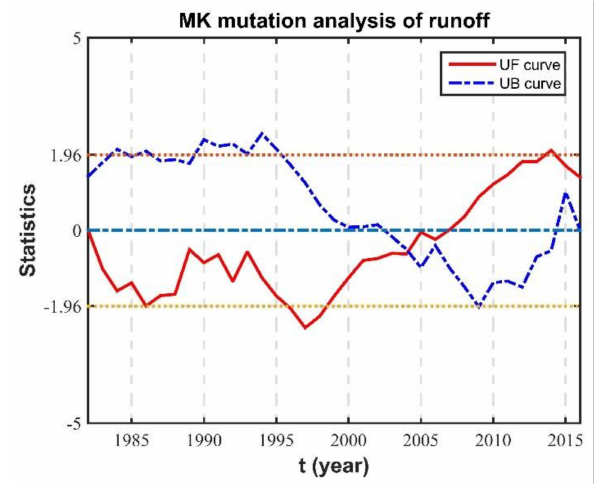
Figure 4. Mann–Kendall mutation test result of runoff in the SAYR from 1982 to 2016.